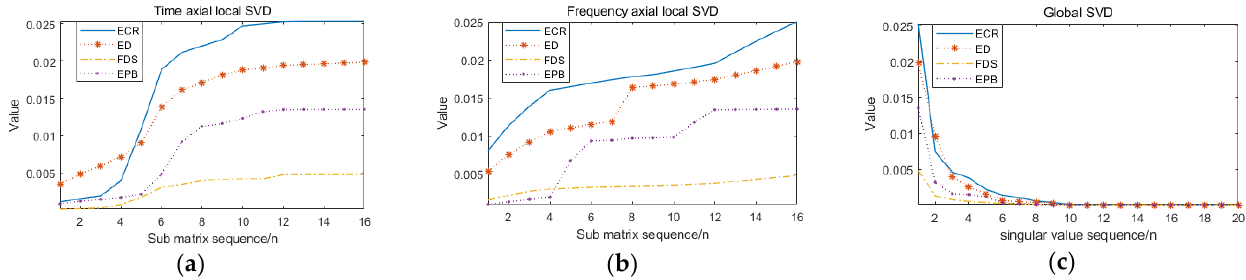
Figure 9. ST diagram of sEMG signals: ( a ) TFM diagram of ECR; ( b ) TFM diagram of ED; ( c ) TFM diagram of FDS; and ( d ) TFM diagram of EPB.